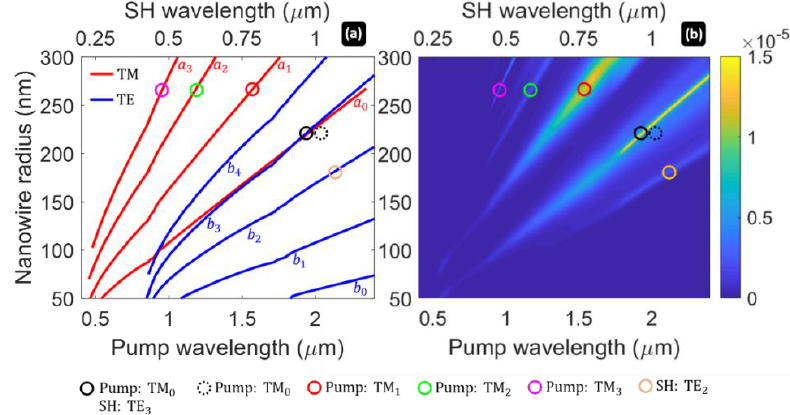
Figure 4. ( a ) Maximum peaks of the Mie scattering coefficients monitored as a function of nanowire radius. For TM-scattering coefficients ( 𝑎 𝑛 ), the wavelength axis is on the bottom (pump wavelength); for TE-scattering coefficients ( 𝑏 𝑛 ), the wavelength axis in on the top (SH wavelength). ( b ) Color map representation of SH scattering efficiency as a function of wavelength and nanowire size. The circles in ( a , b ) highlight scenarios in which either the pump or the SH, or both pump and SH, are coupled to normal modes of the nanowire.